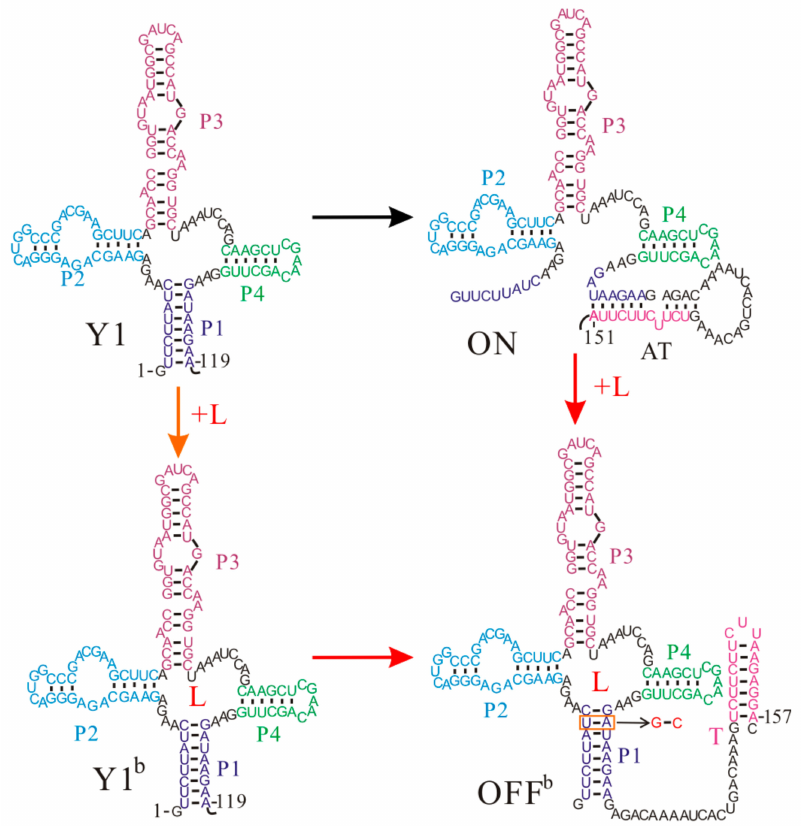
Figure 4. The main co-transcriptional folding pathways of the yitJ S-box riboswitch. helices P1, P2, P3, P4 and the T hairpin are colored differently. L is the ligand SAM. The AU base pair depicted in the red box within OFF b state denotes the mutated base pair